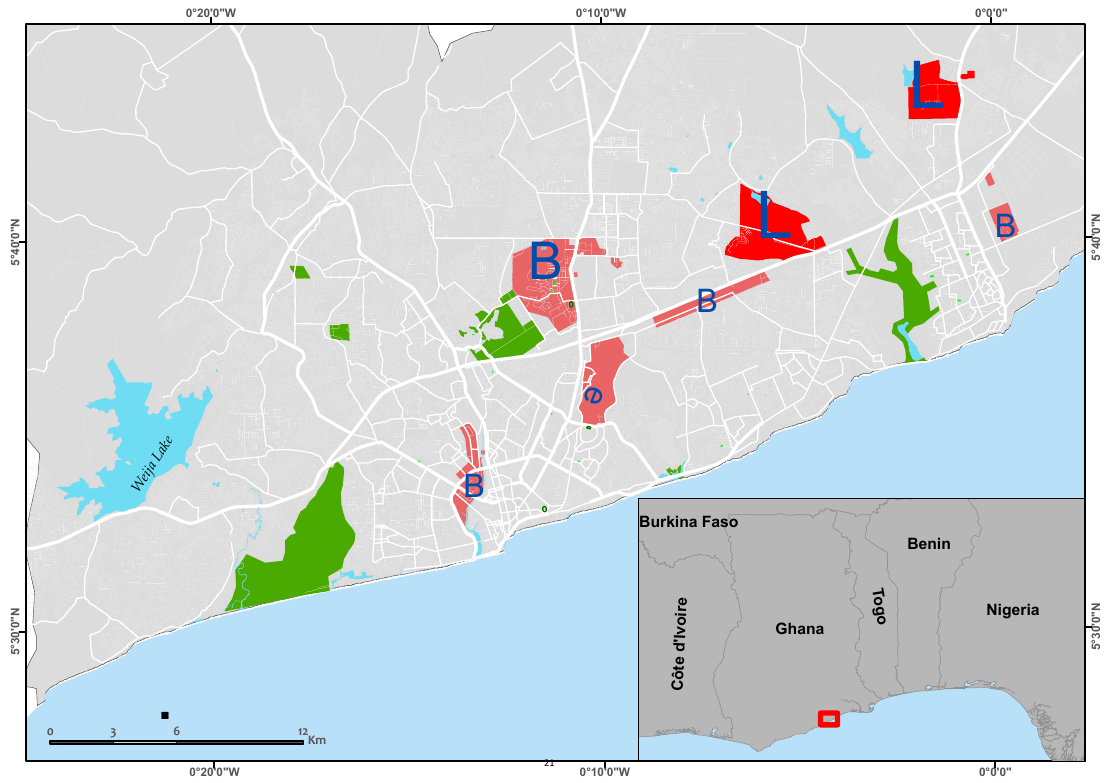
Figure 1. Detailed map of the study area and its relative location on the West African coast.